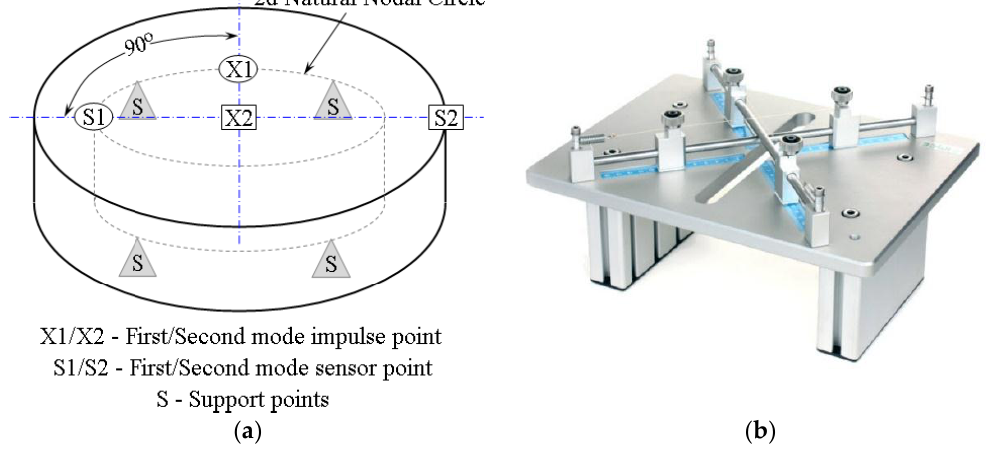
Figure 2. ( a ) Support, impulse, and sensor points for first and second natural vibrations in discs according to ASTM E 1876. ( b )Picture of used precision wire support for foam disc samples.